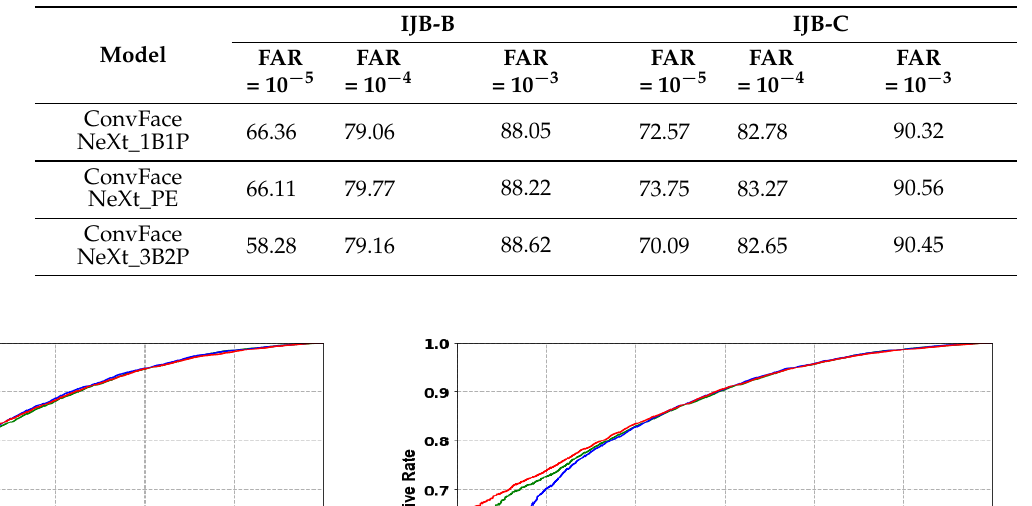
Table 9. Verification accuracy of different amounts of batch normalization and activation functions on IJB-B and IJB-C datasets.